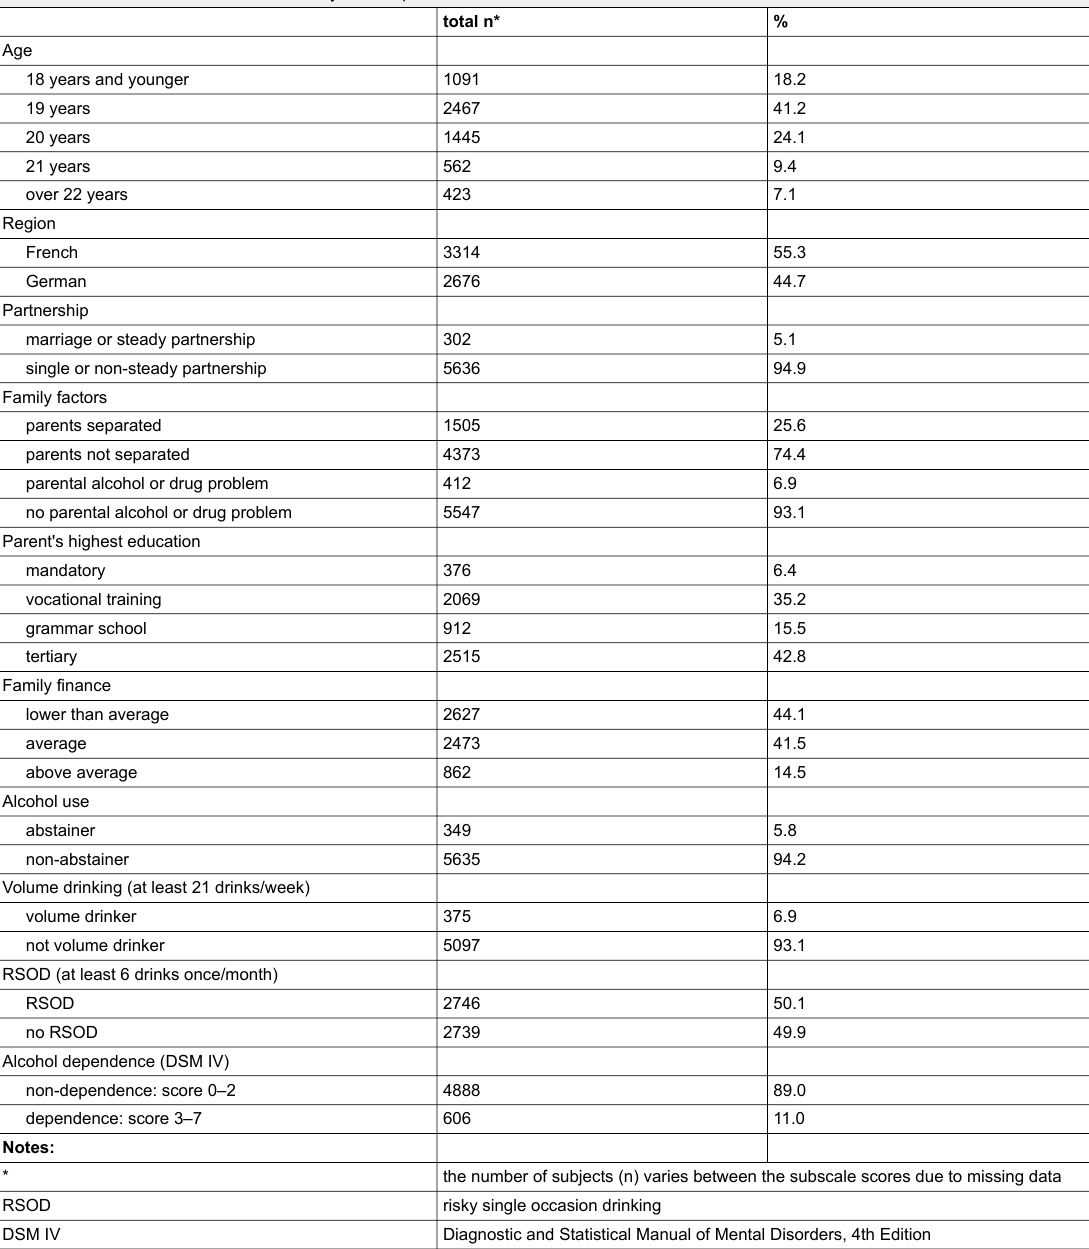
Table 1: Baseline characteristics of the analysed